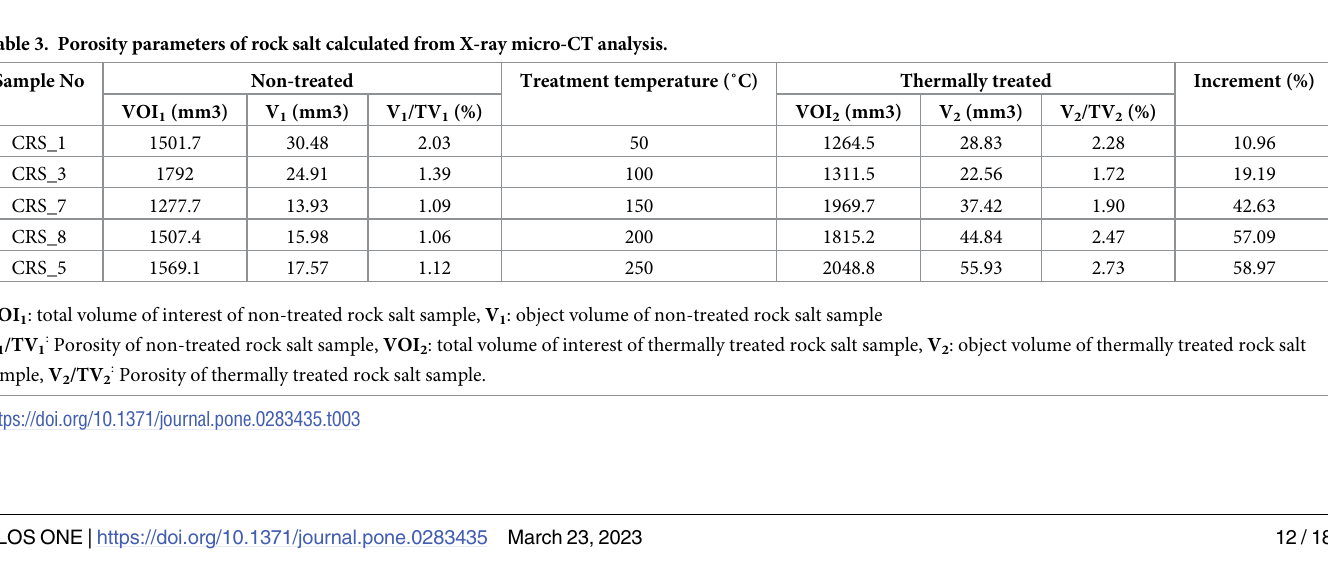
Fig 11. X-ray micro computed scans of the pre-heated and heated rock salt samples.